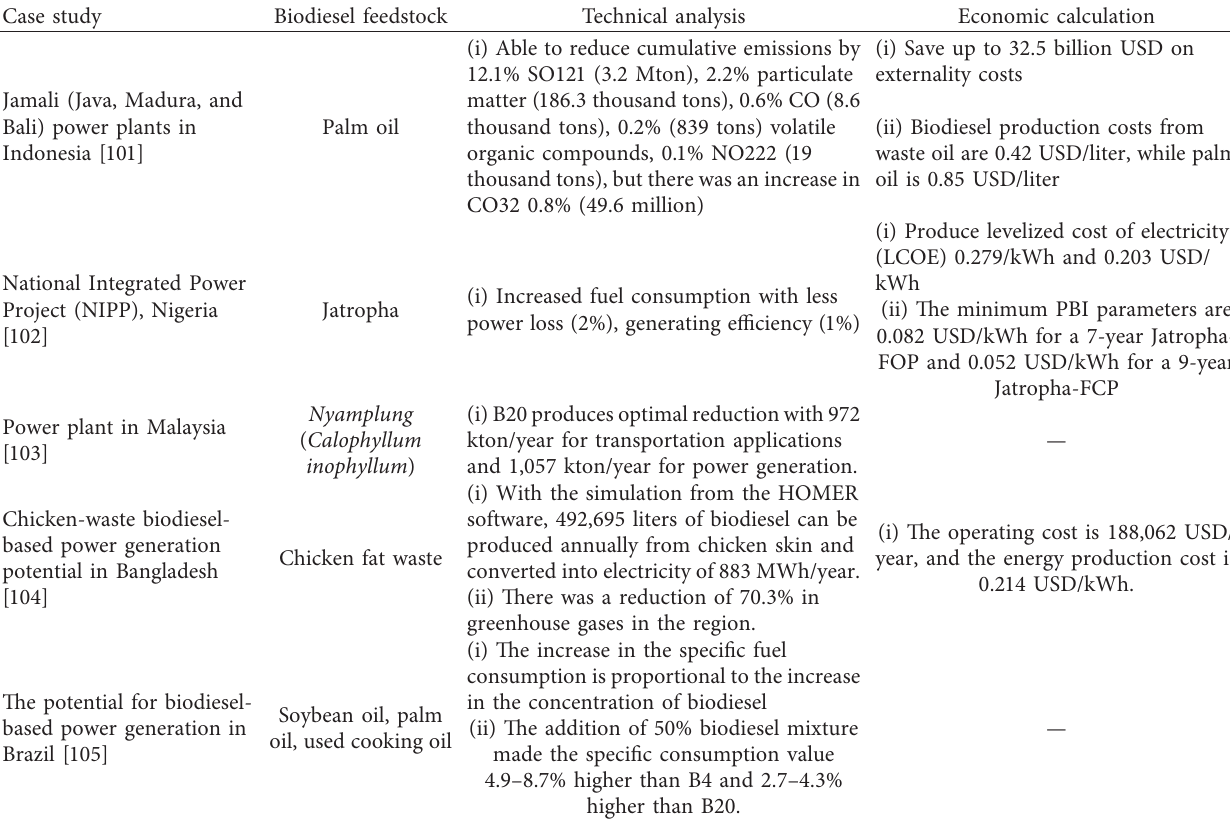
Table 5: Application of various biodiesel mixtures in the power